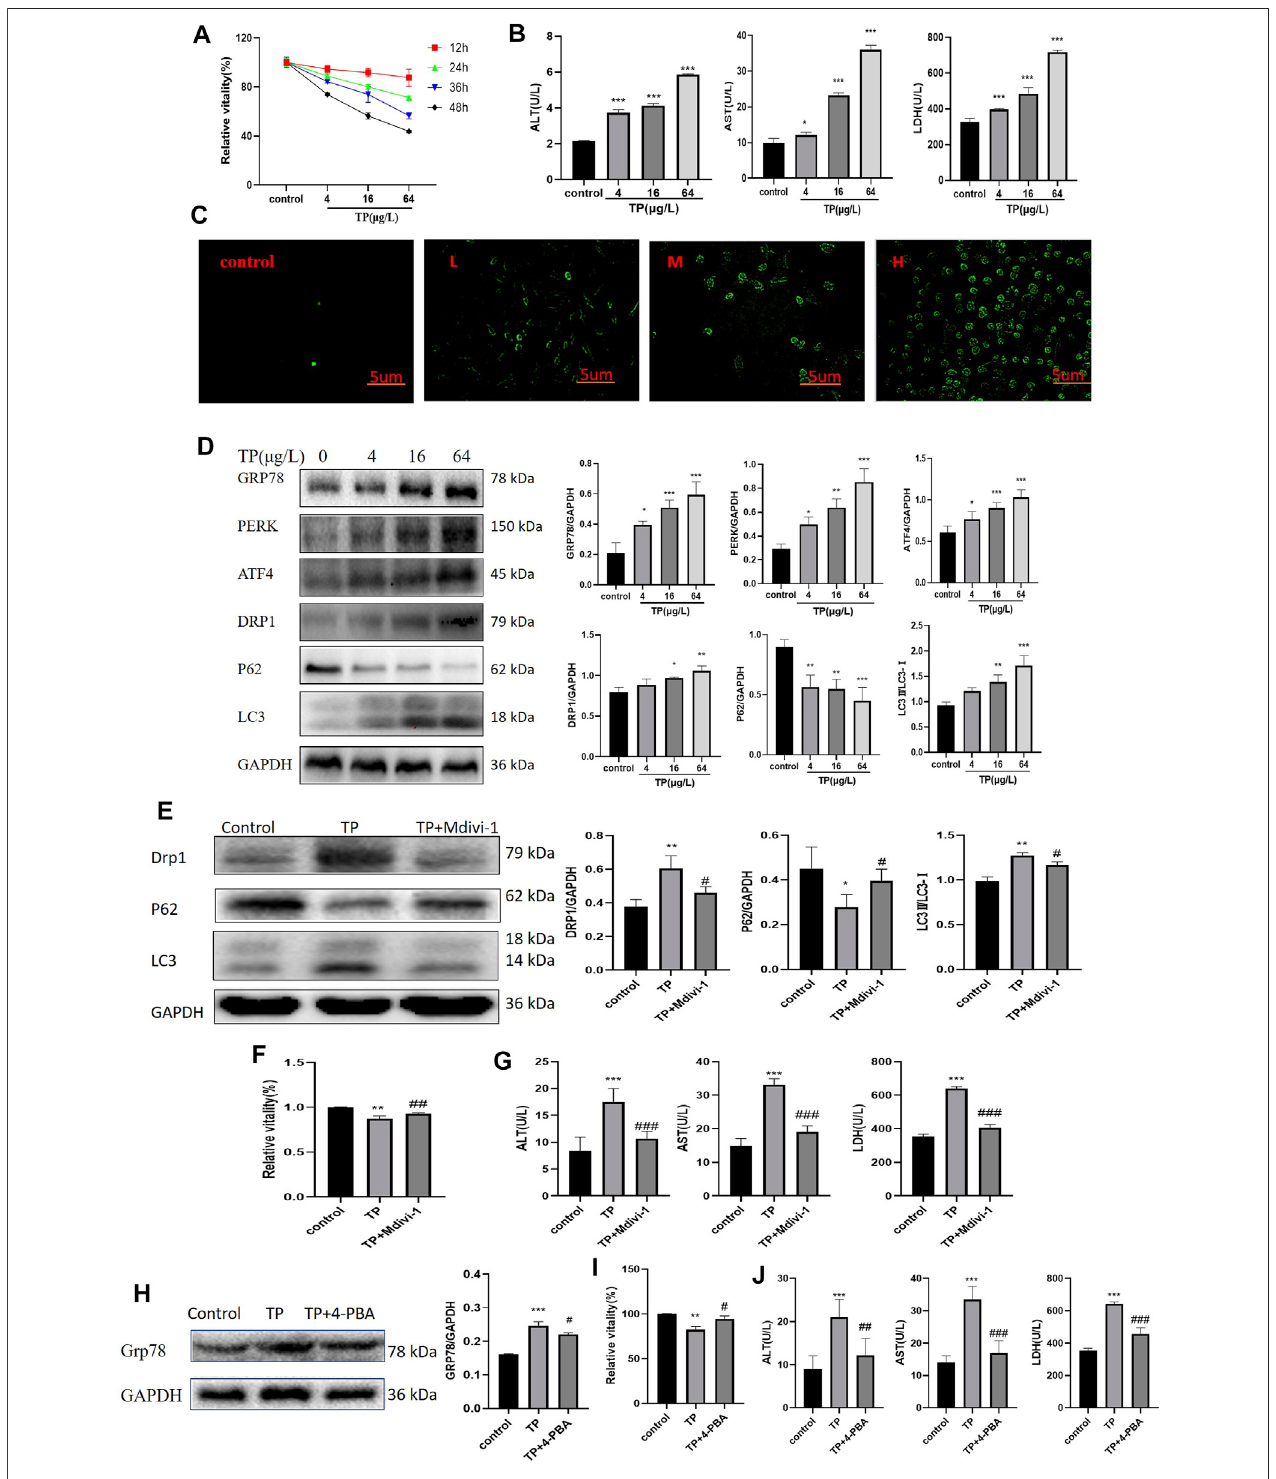
FIGURE5| InhibitionofmitophagyandERSattenuatedTP-inducedcytotoxicityinHepaRGcells. (A) Theeffectof4 – 64 μ g/LTPontheviabilityofHepaRGcellsfor 12,24,36,and48 h, respectively. (B) 4 – 64 μ g/LTPledtotheincrease ofALT,AST,andLDH indexesinthesupernatantofHepaRG cells. (C) 4 – 64 μ g/LTPcausedthe increase of autophagosome production in HepaRG cells. Green fl uorescence represented autophagosome. 200 magni fi cation, Scale bar: 5 µm. (D) The effect of 4 – 64 μ g/L TP on the expression of GRP78, PERK, ATF4, DRP1, P62, and LC3 in HepaRG cells. (E) The effect on the expression levels of DRP1, P62, and LC3 in cellsbyinhibitingmitophagybyMidivi-1. (F) TheeffectoncellviabilitybyinhibitingmitophagybyMidivi-1. (G) TheeffectonALT,AST,andLDHindexesinthesupernatant